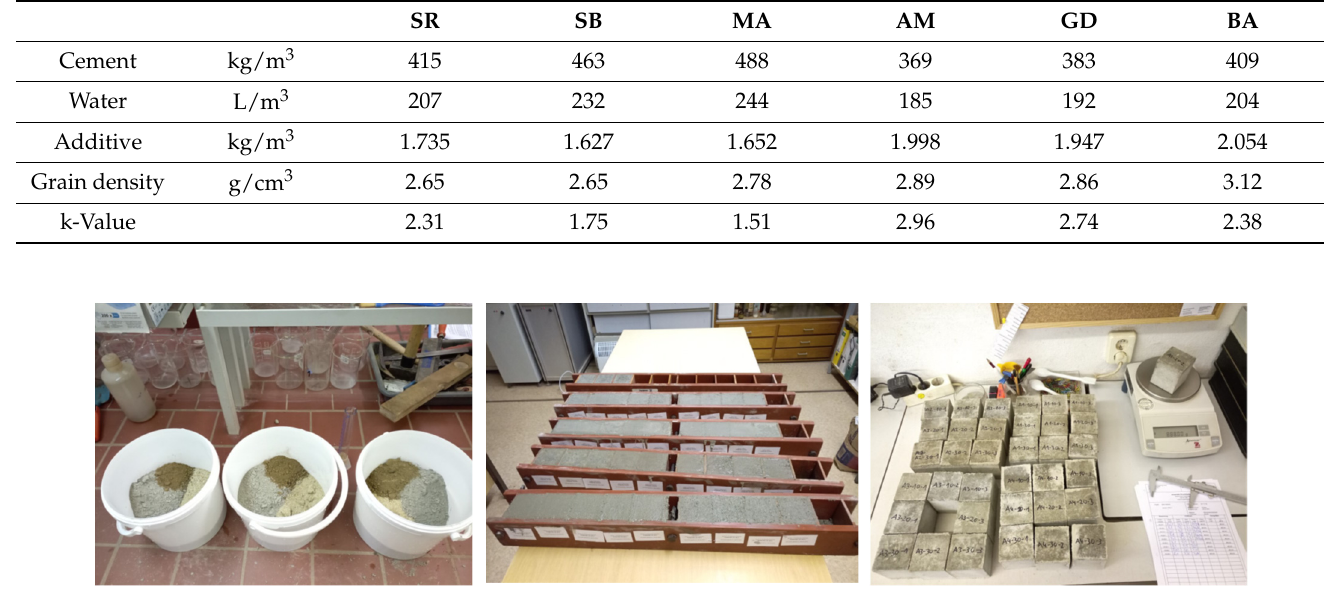
Figure 4. Manufacturing of the test specimens (Figure source: Radek Kucera).